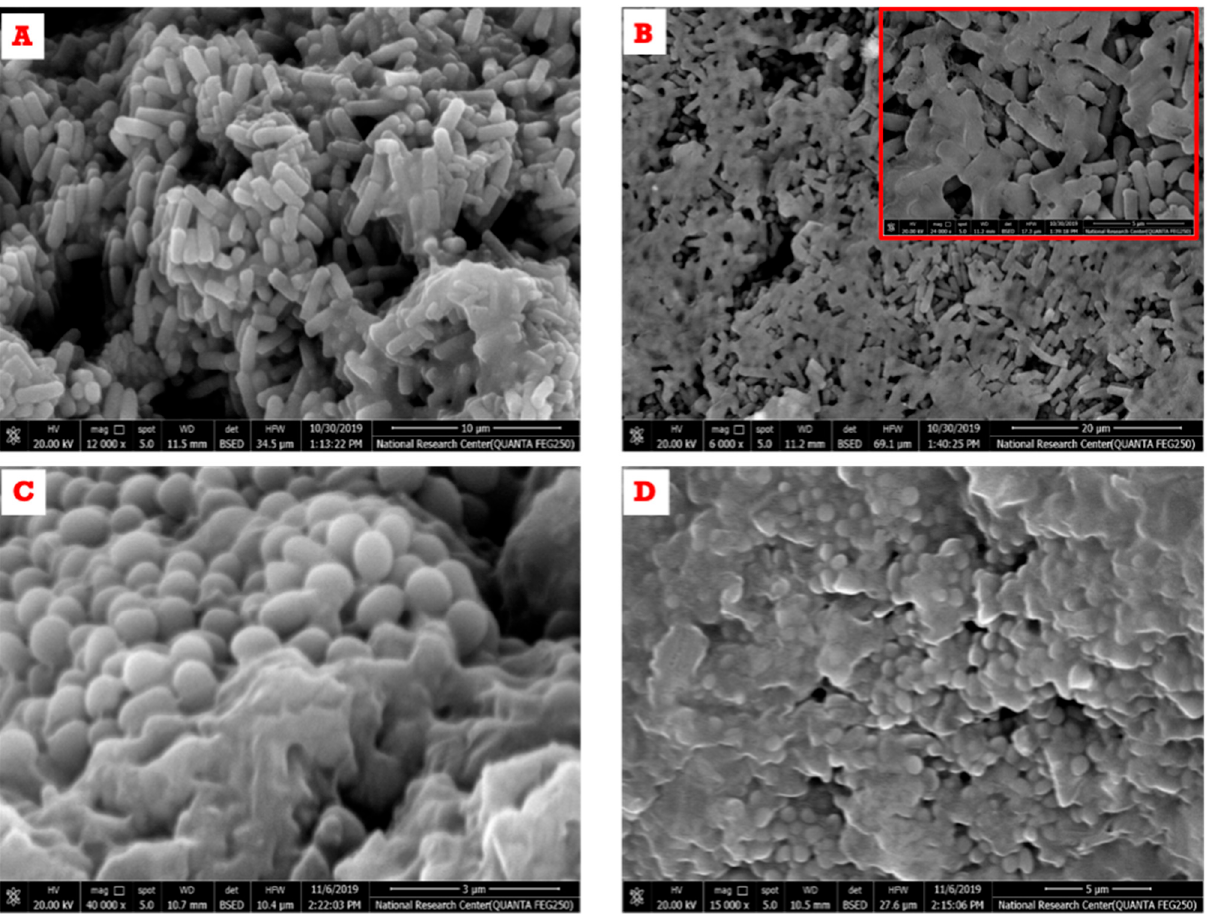
Figure 10. Field emission-scanning electron microscope (FE-SEM) photography of C. albicans and S. aureus before and after treatment with anise oil-based nanoemulsions. ( A ): untreated C. albicans cells, ( B ): treated C. albicans , ( C ): untreated S. aureus cells and ( D ): treated S. aureus cells.